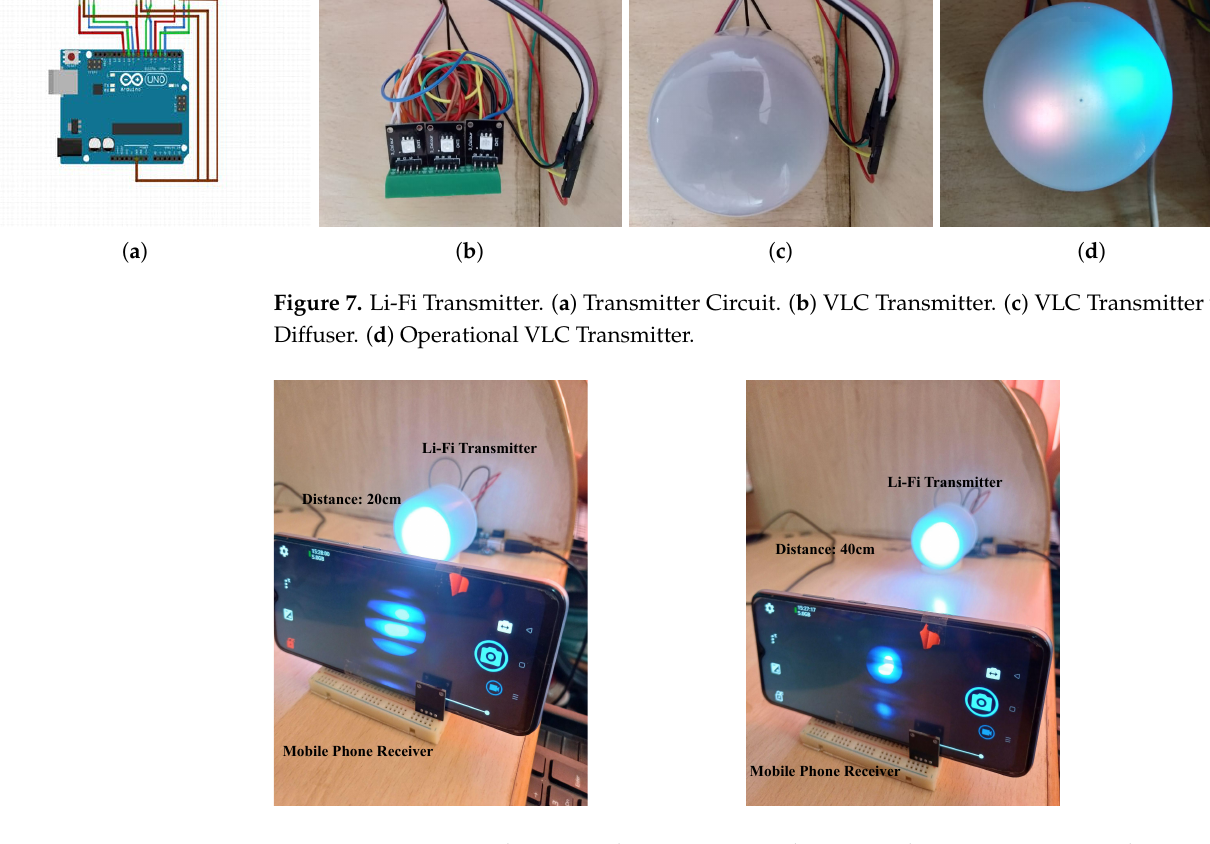
Figure 8. Experimental Setup with Transmitter and Receiver distances as 20 cm and 40 cm from left